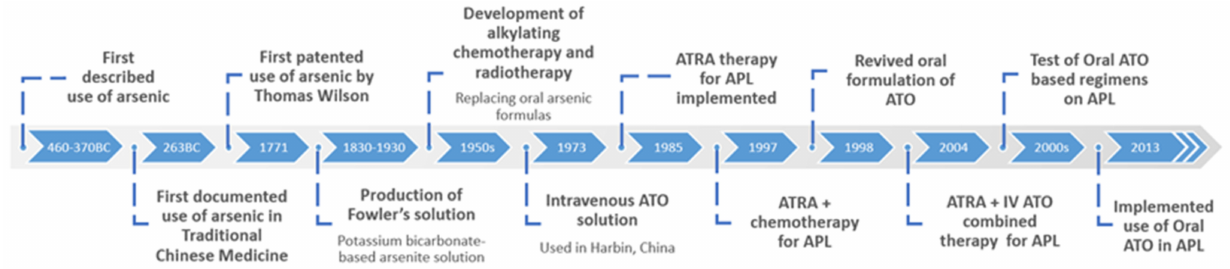
Figure 2. Timeline of advances in APL treatment and the development of oral arsenic trioxide